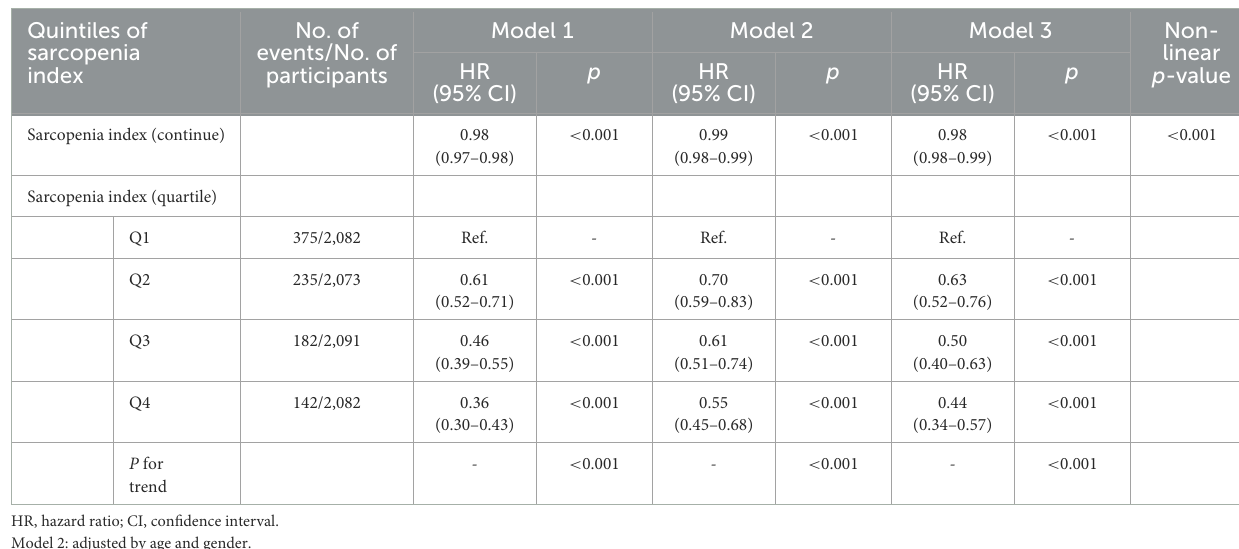
TABLE 3 Association between SI and all-cause mortality in different model.